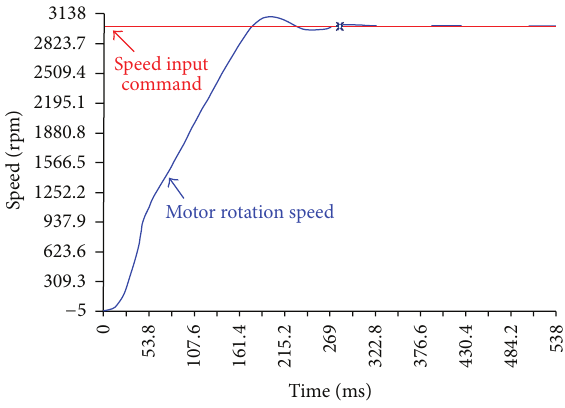
Figure 13: Experimental starting response of three-phase PMSM at no load and rated speed.